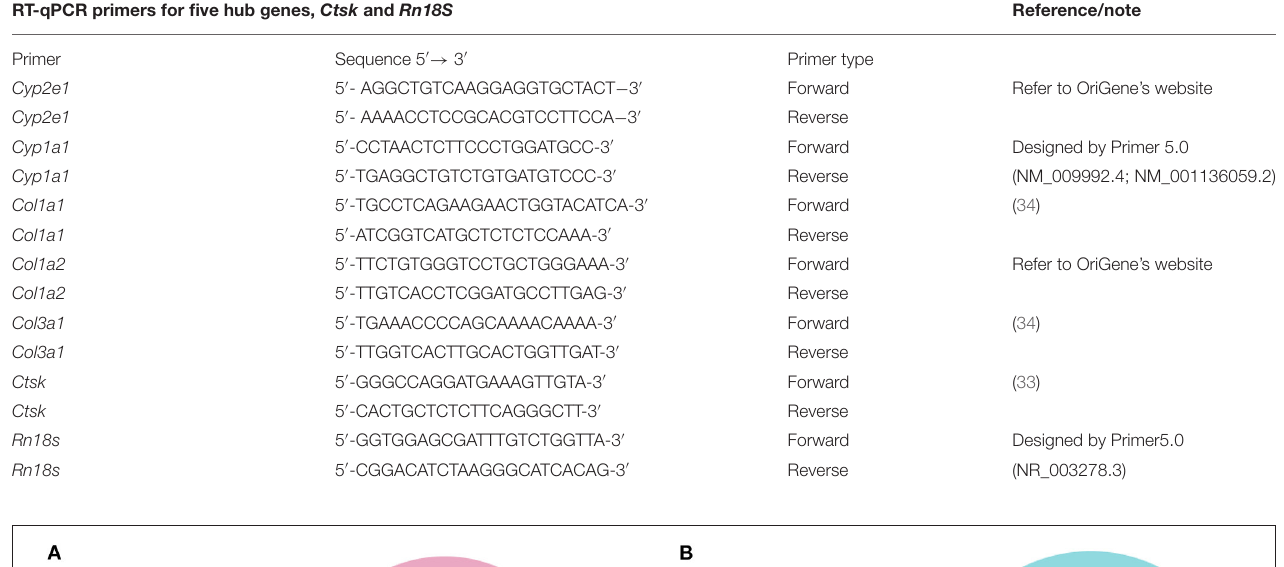
TABLE 1 | Primer sequence for RT-qPCR. RT-qPCR primers for five hub genes, Ctsk and Rn18S